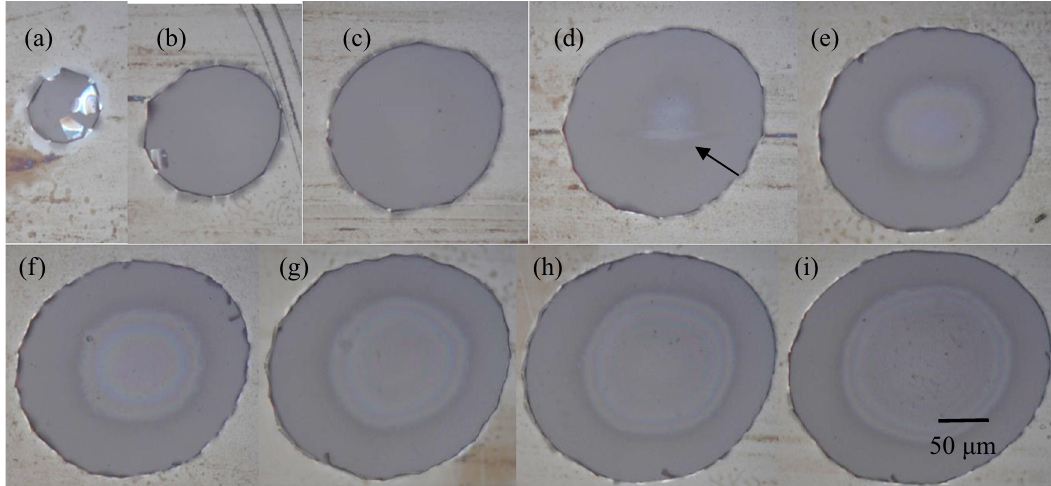
Figure 7: Fs laser removal of ITO on PET from 85 to 608 μ J. The central region is modi fi ed at 250 μ J and above ( indicated by the arrow ) . ( a ) 85 μ J, ( b ) 134 μ J, ( c ) 184 μ J, ( d ) 250 μ J, ( e ) 317 μ J, ( f ) 388 μ J, ( g ) 458 μ J, ( h ) 521 μ J, ( i ) 608 μ